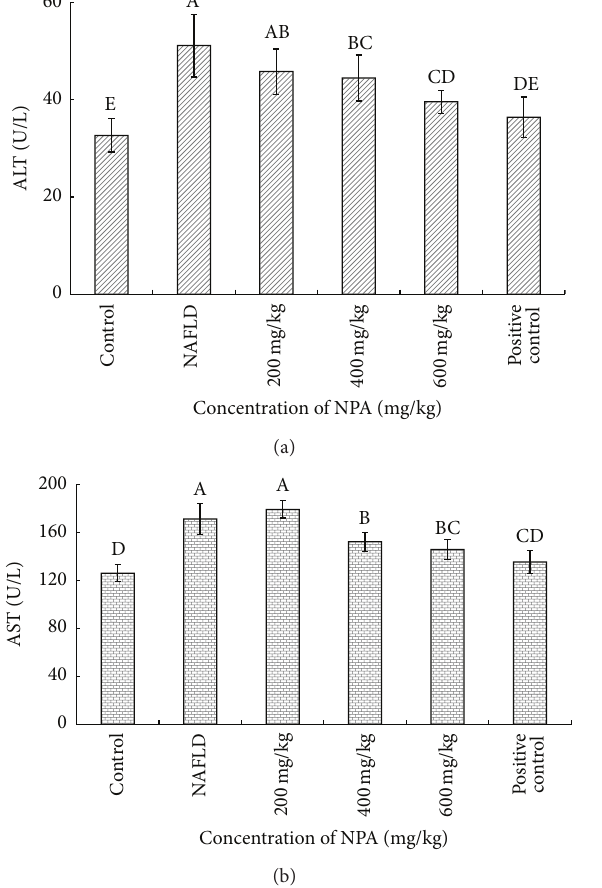
Figure 1: Effect of different concentrations of NPA on serum levels of ALT (a) and AST (b) in each group of rats. Different letters (A, B, C,orD)uponeachcolumnrepresentsignificantdifferencesbetween the treated groups ( 𝑃 < 0.05